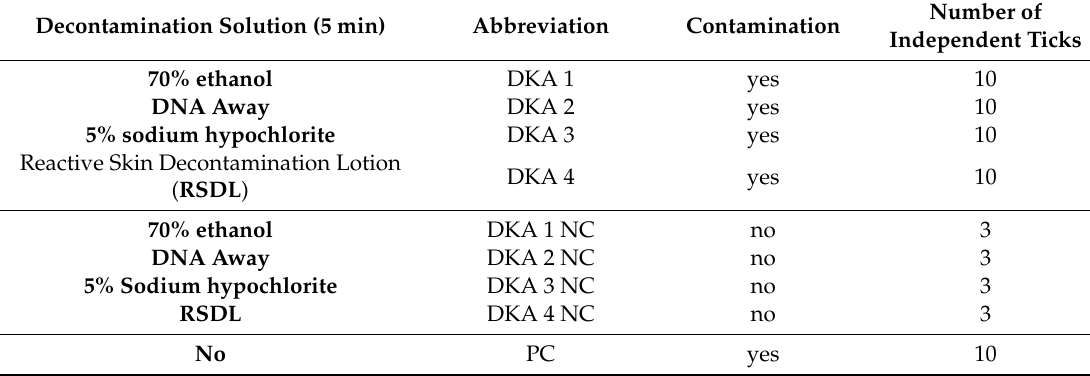
Table 1. Decontamination strategies to assess the e ffi ciency of four decontamination solutions.